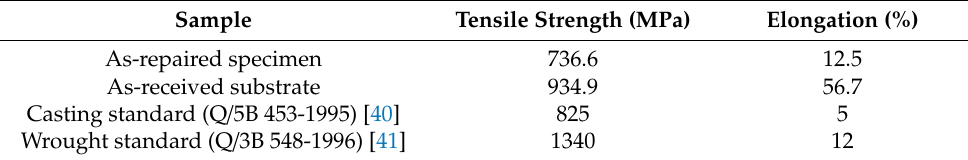
Table 2. Tensile properties of the laser-repaired samples and the substrate.